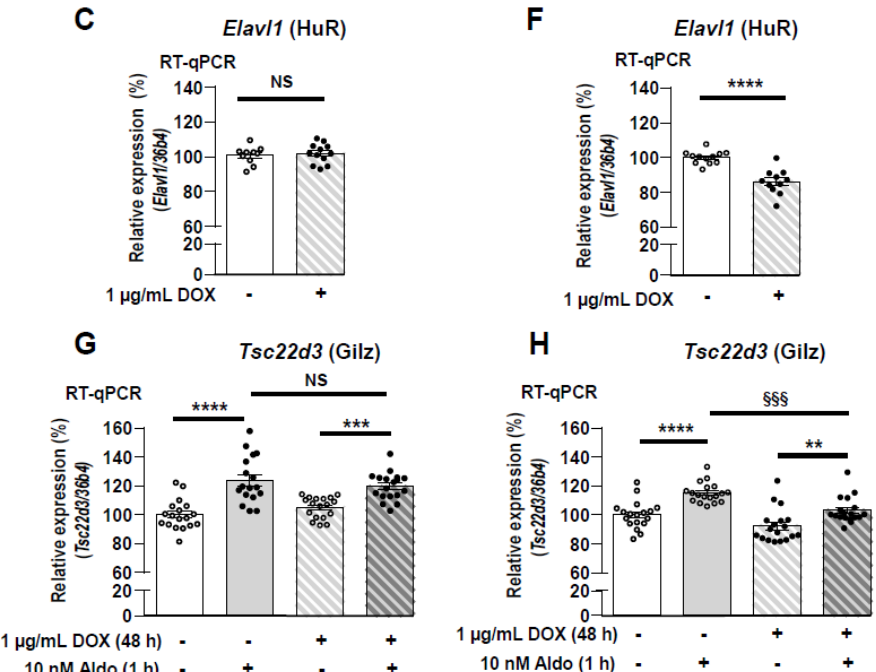
Figure 6. Impairment of MR signaling in KC3AC1 cells stably expressing miR-324-5p. miR-324-5p ( A , D ), Nr3c2 (MR) ( B , E ) and Elavl1 (HuR) ( C , F ) expression were determined by RT-qPCR, 48 h after doxycycline induction (1 µ g/mL) in KC3AC1 clones stably transduced with lentiviral particles expressing inducible scrambled miRNAs (Sm-A1 clone, left panels) or miR-324-5p (Sh-H8 clone, right panels). Data are means ± SEMs from two independent experiments performed in six replicates ( n = 12). NS = not significant, *** p < 0.001, **** p < 0.0001 compared to the condition in absence of doxycycline, arbitrarily set at 100%. ( G , H ) Sm-A1 and Sh-H8 clones were deprived in minimal medium for 48 h and incubated for 48 h with 1 µ g/mL doxycycline. Thereafter, Sm-A1 and Sh-H8 clones were stimulated for 1 h with 10 nM aldosterone and Tsc22d3 (Gilz) expression ( G , H ) was quantified by RT-qPCR where basal Gilz expression in renal cells, in the absence of DOX and aldosterone, was arbitrarily set at 100%. Data are means ± SEMs from three independent experiments performed in six replicates per condition ( n = 18). NS = not significant. ** p < 0.01 *** p < 0.001 **** p < 0.0001 compared to the condition without aldosterone stimulation, arbitrarily set at 100%. §§§ indicate p < 0.001 between the two conditions indicated by line.